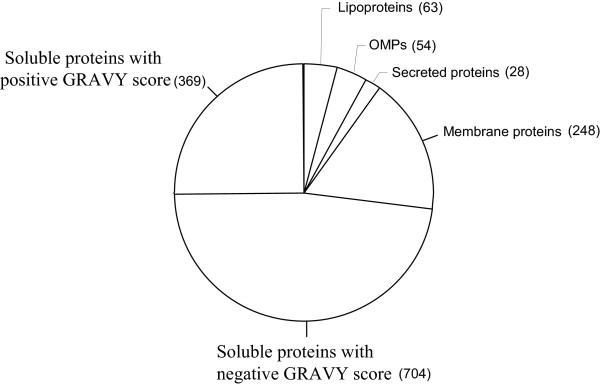
Number of proteins within main functional categories identified in the Triton X-114 detergent phase prepared from M. tuberculosis H37Rv.